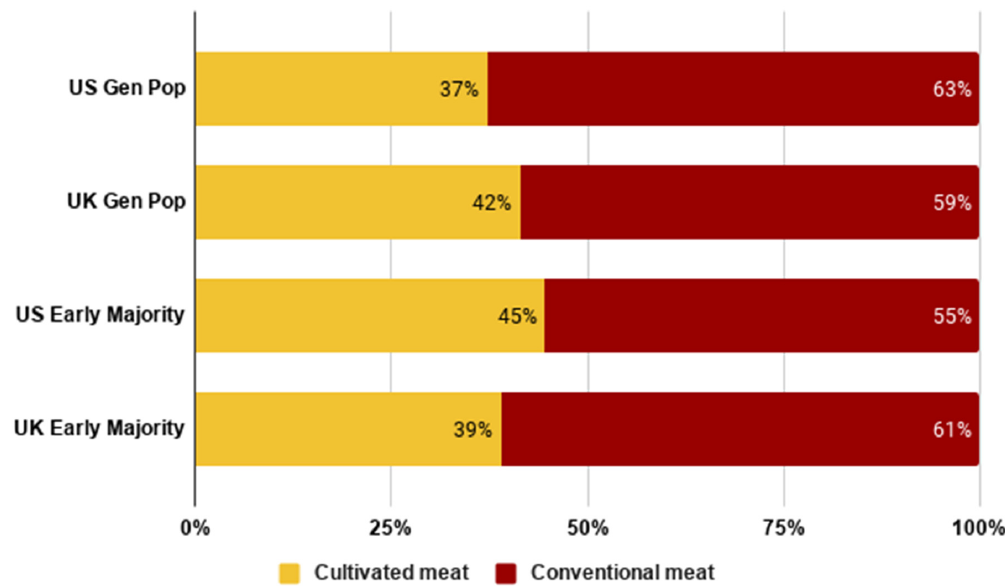
Figure 11. Average expected percentage of meat from each production method by country and segment.